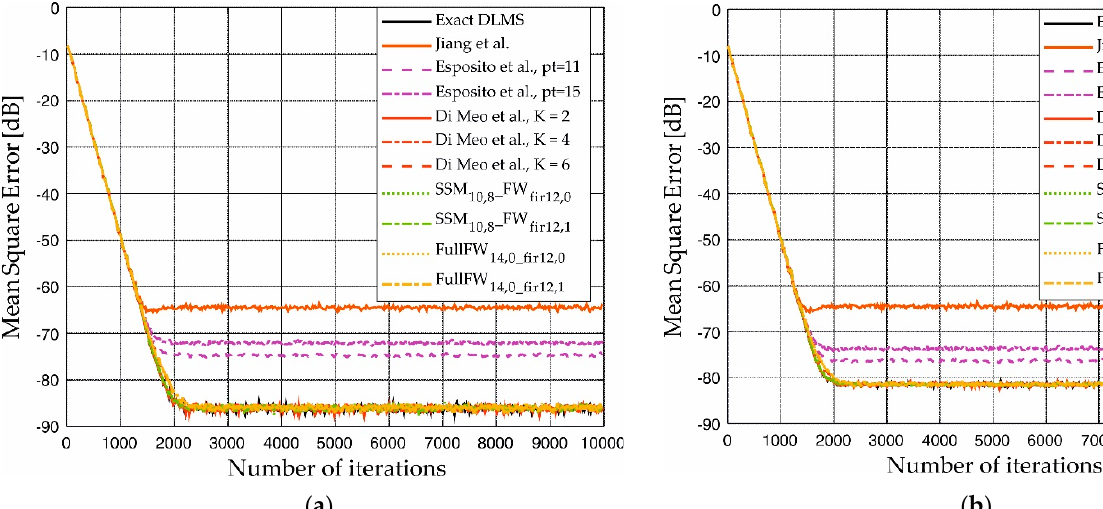
Figure 13. Learning curves in the case of ( a ) FIR identification and ( b ) IIR identification with approximation in the learning and in the FIR sections. The learning curves of the implementations Jiang et al. [20], Esposito et al. [37], and Di Meo et al. [41] are reported for the sake of comparison.